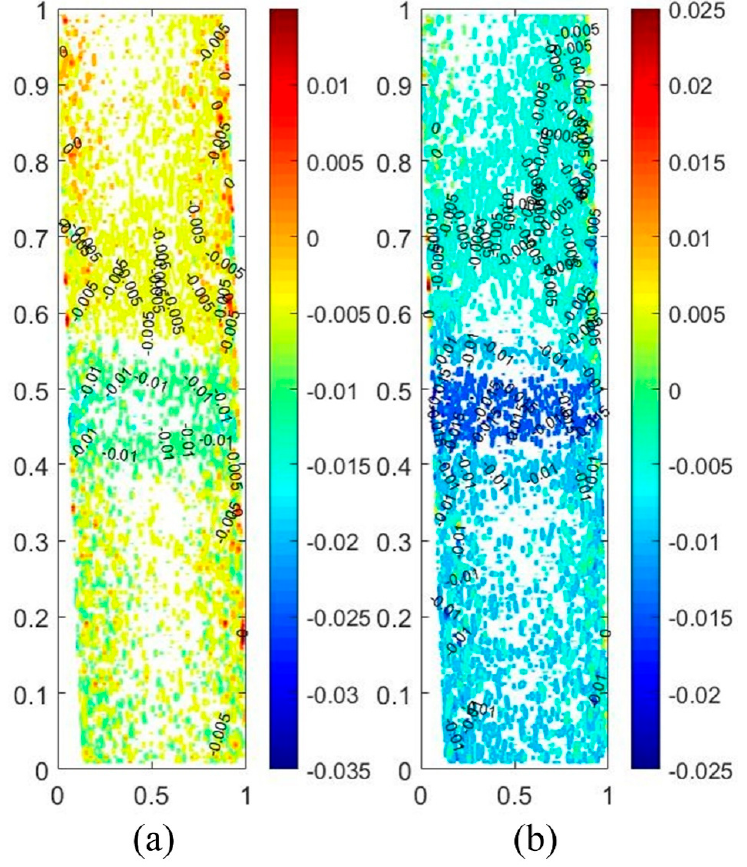
Figure 16. Out-of-plane displacement contour of S1 (unit: cm): ( a ) Δ F = 600 N, ( b ) Δ F = 1000 N.